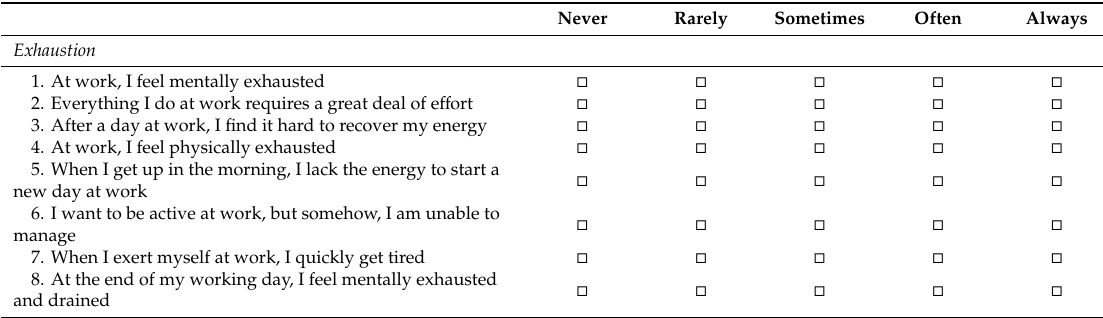
Table A2. Core Symptoms